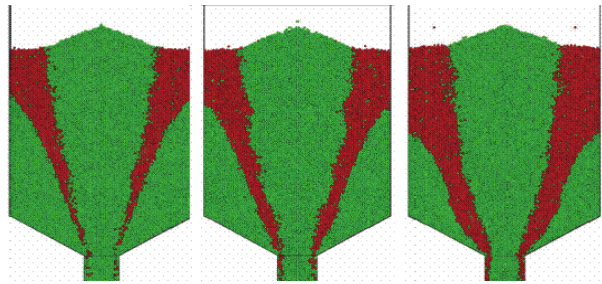
Figure 2: Sketch of the stagnant zone of different time with the side area method with DEM method.